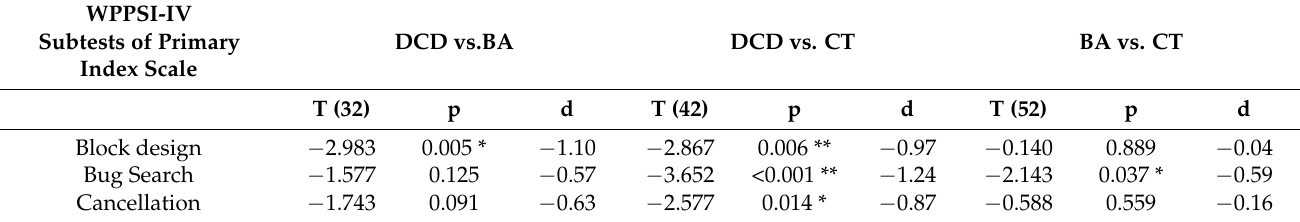
Table A4. Post-hoc group t -test comparisons for subtests with significant ANOVA